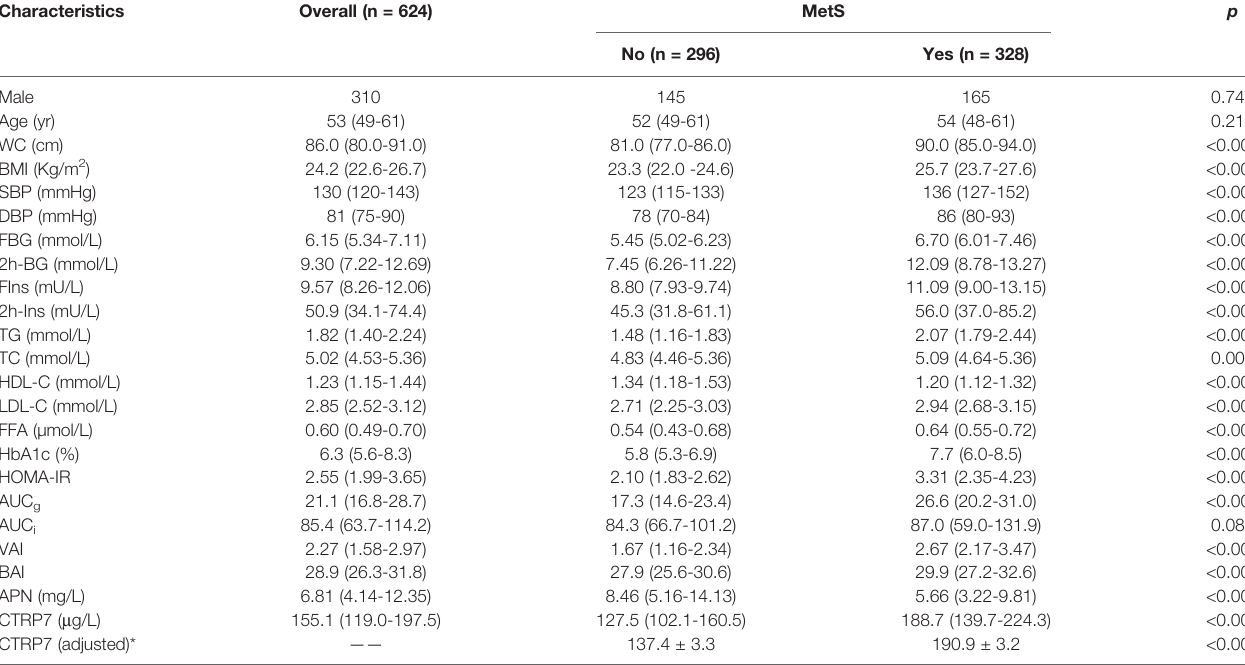
TABLE 1 | Main clinical features and serum CTRP7 levels in MetS and control subjects.